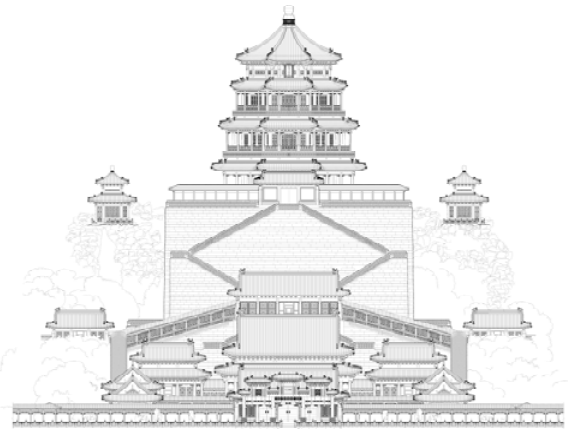
Fig.11. An elevation of the Paiyun Hall 排云殿 Group , 2006